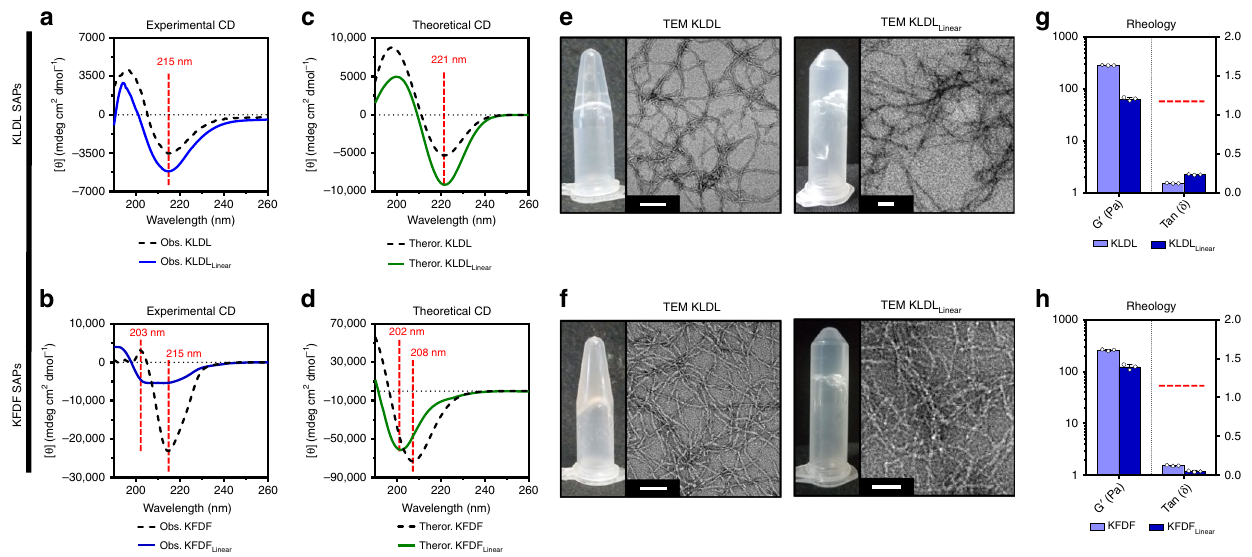
Fig. 3 Impact of self-assembling peptide (SAP) functionalization on assembly properties. a Experimental circular dichroism (CD) spectra of KLDL (black dashed line) and KLDL Linear (blue line) SAPs, with labeled minimum at 215 nm (n → π *). b Experimental CD spectra of KFDF (black dashed line) and KFDF Linear (blue line) SAPs, with labeled minima at 215 nm (n → π *) and 203 nm ( π → π *). c Theoretical CD spectra of KLDL (black dashed line) and KLDL Linear (green line) SAPs from DichroCalc simulations using FibPredictor models. d Theoretical CD spectra of KFDF (black dashed line) and KFDF Linear (green line) SAPs from DichroCalc simulations using FibPredictor models (see Supplementary Tables 3-4). CD spectra minima denoted with dashed lines. e Assembled hydrogel photographs and corresponding transmission electron microscopy (TEM) images of the KLDL (left) and KLDL Linear (right) SAPs. f Assembled hydrogel photographs and corresponding TEM images of the KFDF (left) and KFDF Linear (right) SAPs. Scale bar 50 nm. g Viscoelastic measurements of storage moduli, G ’ (Pa), and damping factor, tan δ , for KLDL (light blue) and KLDL Linear (dark blue). h Viscoelastic measurements of storage moduli, G ’ (Pa), and damping factor, tan δ , for KFDF and KFDF Linear . Gel capacity is de fi ned as tan δ < 1 (dashed line). CD measurements